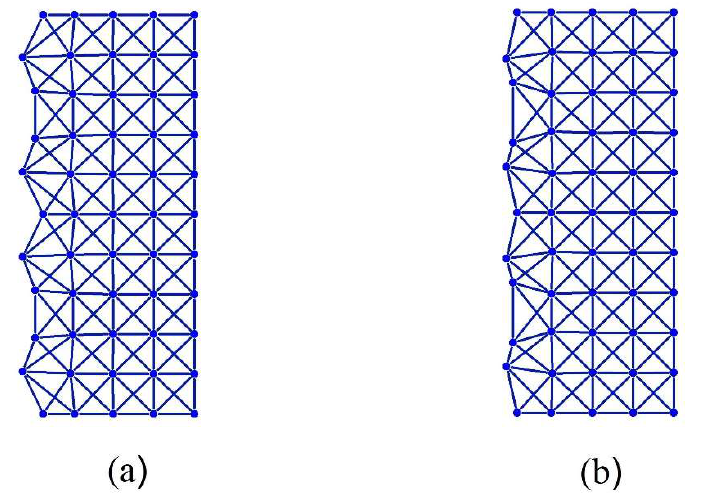
(cid:2872) π , 𝜋 , 𝑚 = 0 → 5 (cid:2873) (cid:2872) 𝜋 , 𝑚 = 0 → (cid:2873)